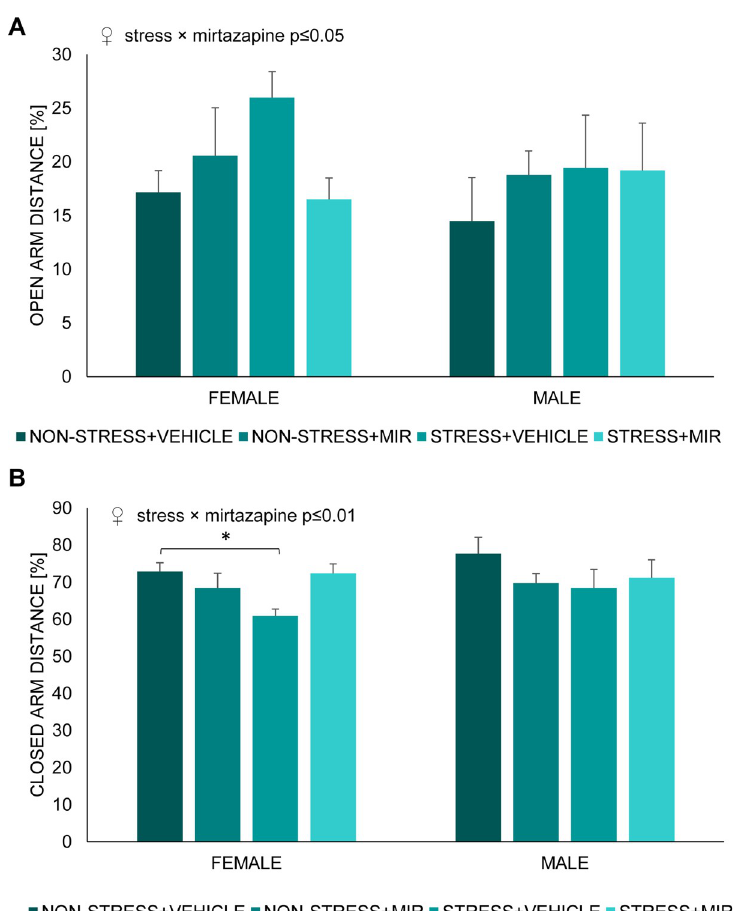
Fig 6. Percentage of distance travelled in individual arms of elevated plus maze by juvenile animals. (A) open arm distance, (B) closed arm distance. Data represent mean ± SEM. n = 7–8 animals/group/sex. MIR- mirtazapine; � p �